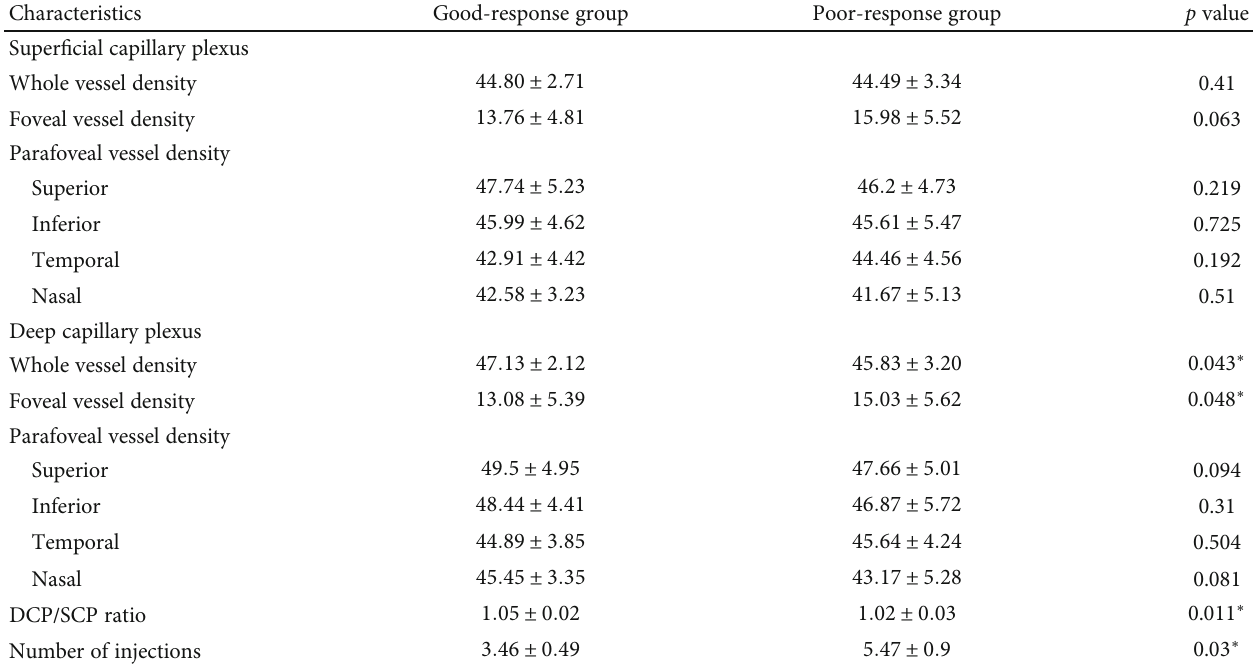
Table 3: Clinical characteristics according to the DME treatment response.